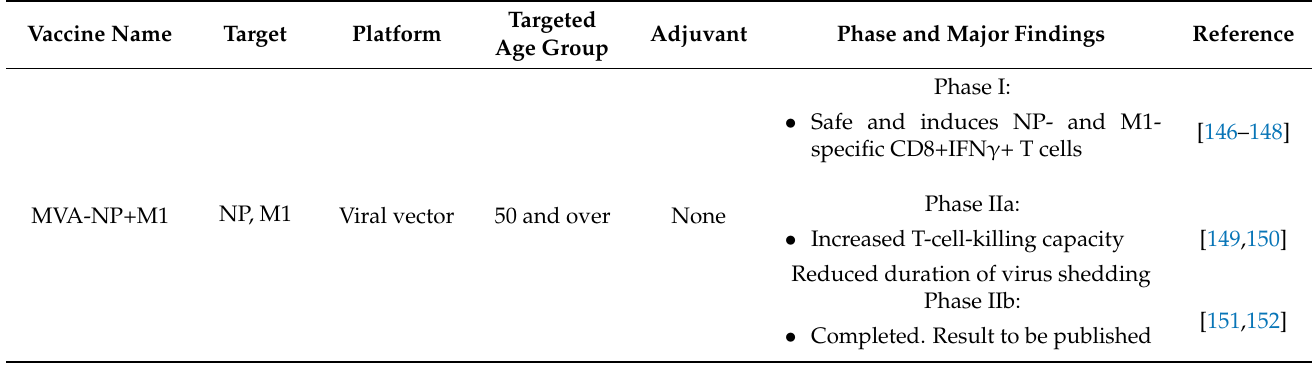
Table 1. Universal vaccine candidates in clinical trials (December